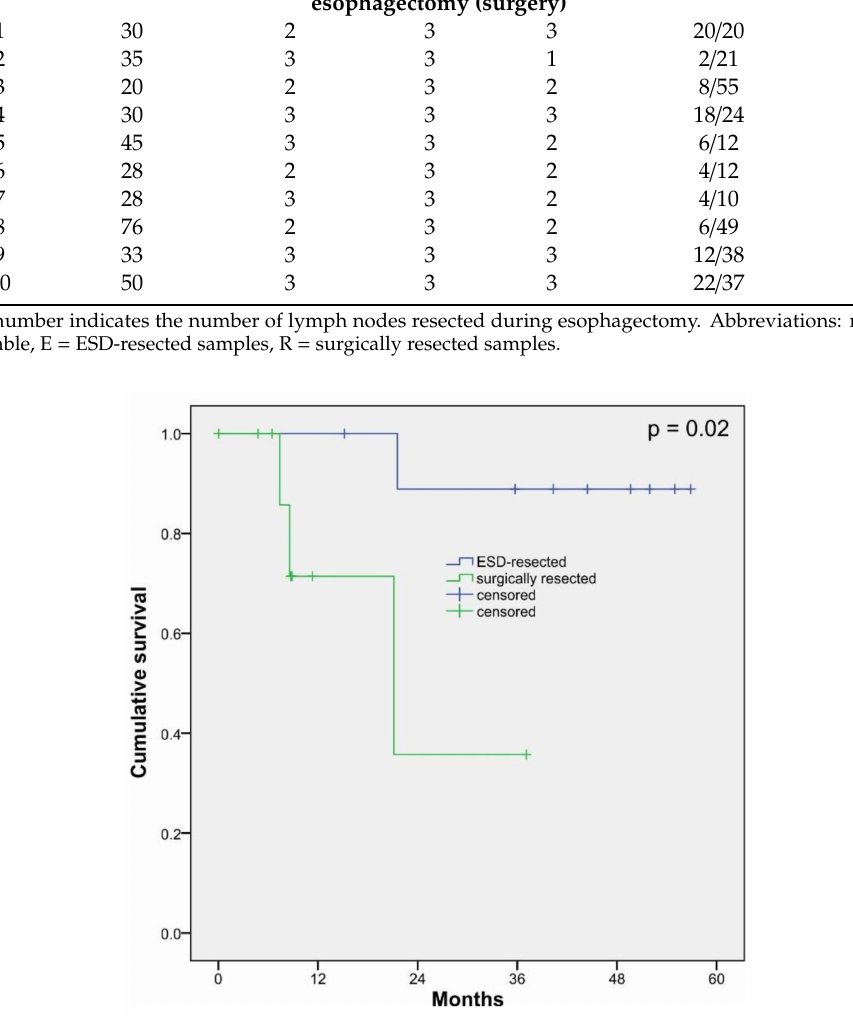
Figure 1. Kaplan–Meier survival analysis of endoscopic submucosal dissection (ESD)-resected cases (blue) and surgically resected cases (green) of esophageal adenocarcinoma. The analyzed cohort consisted of a total of 20 patients ( n = 20) who underwent ESD ( n = 10) or surgical resection ( n =